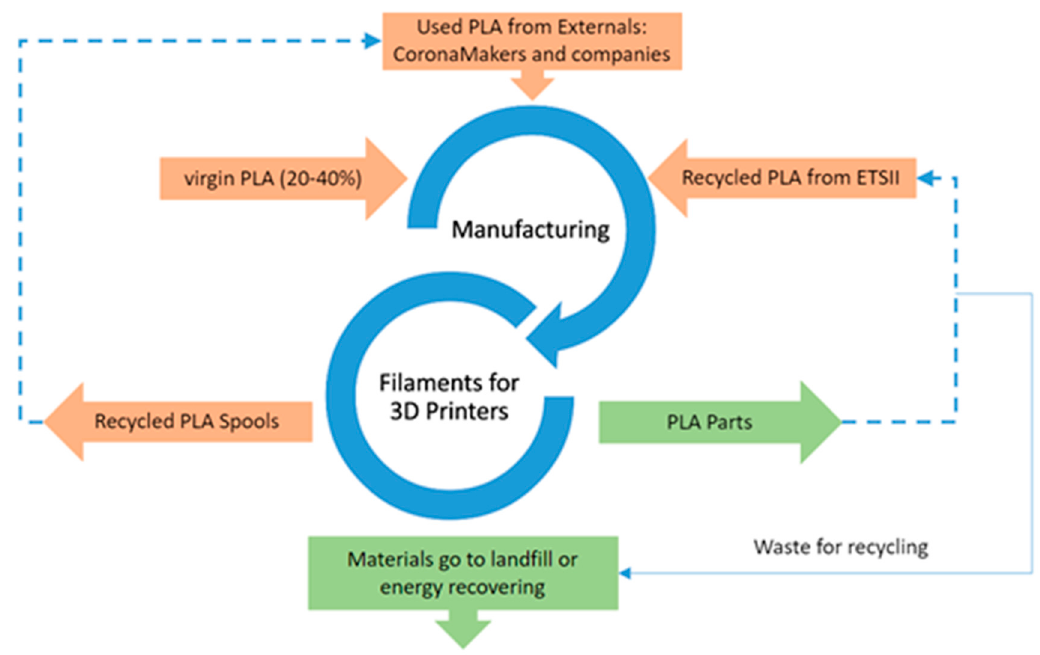
Figure 4. Materials flow for recycled filaments for 3D printers.